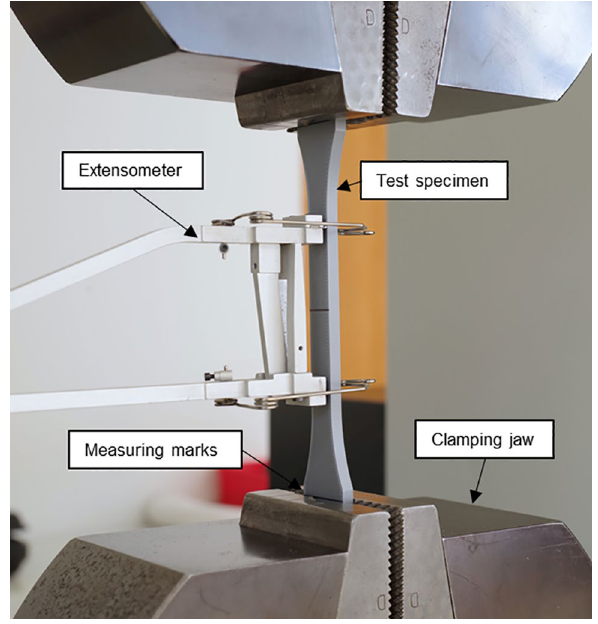
Fig. 7 Test setup for the tensile strength